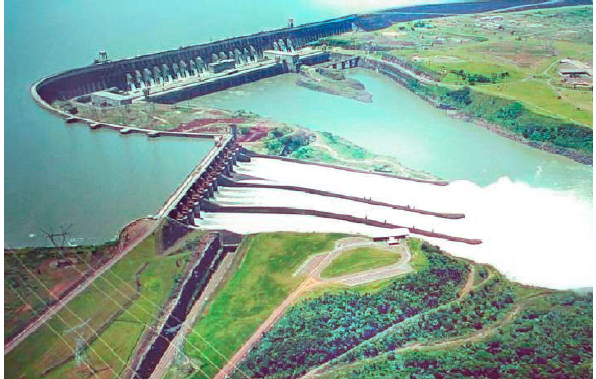
Figure 1. Itaipu Dam,